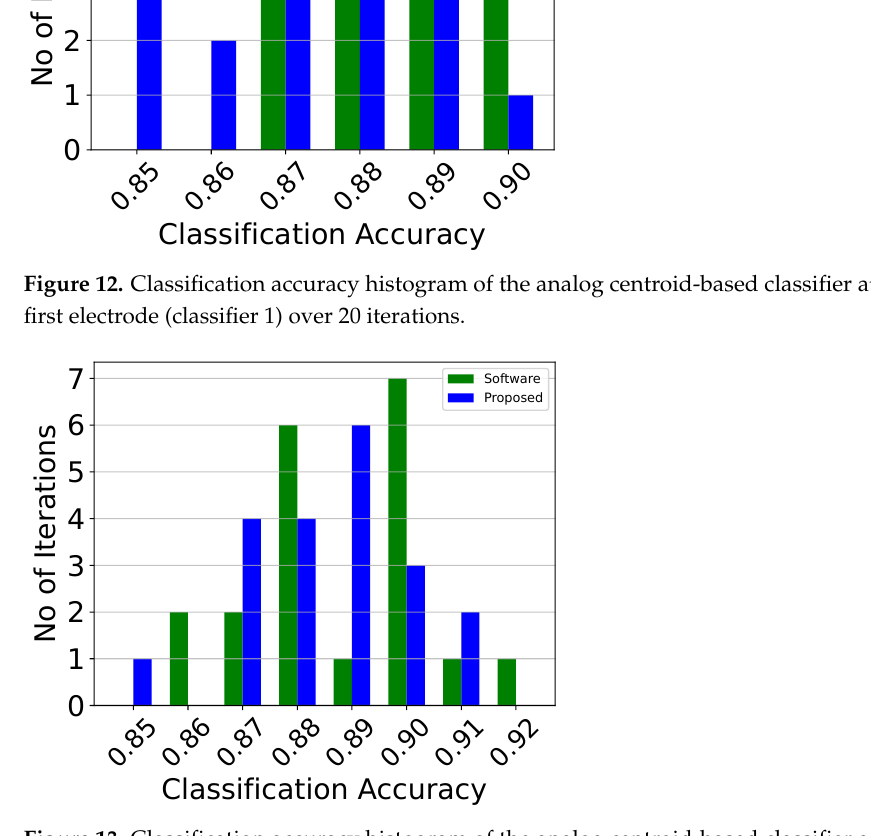
Figure 13. Classification accuracy histogram of the analog centroid-based classifier attached to the second electrode (classifier 2), over 20